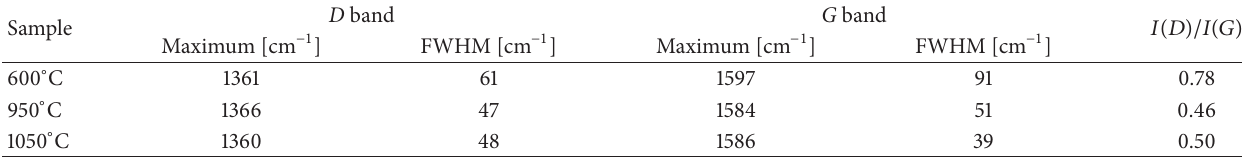
Table 4: Properties of D and G bands observed for the Ni 2 Si/ 𝑛 -SiC contacts annealed at 600, 950, and 1050 ∘